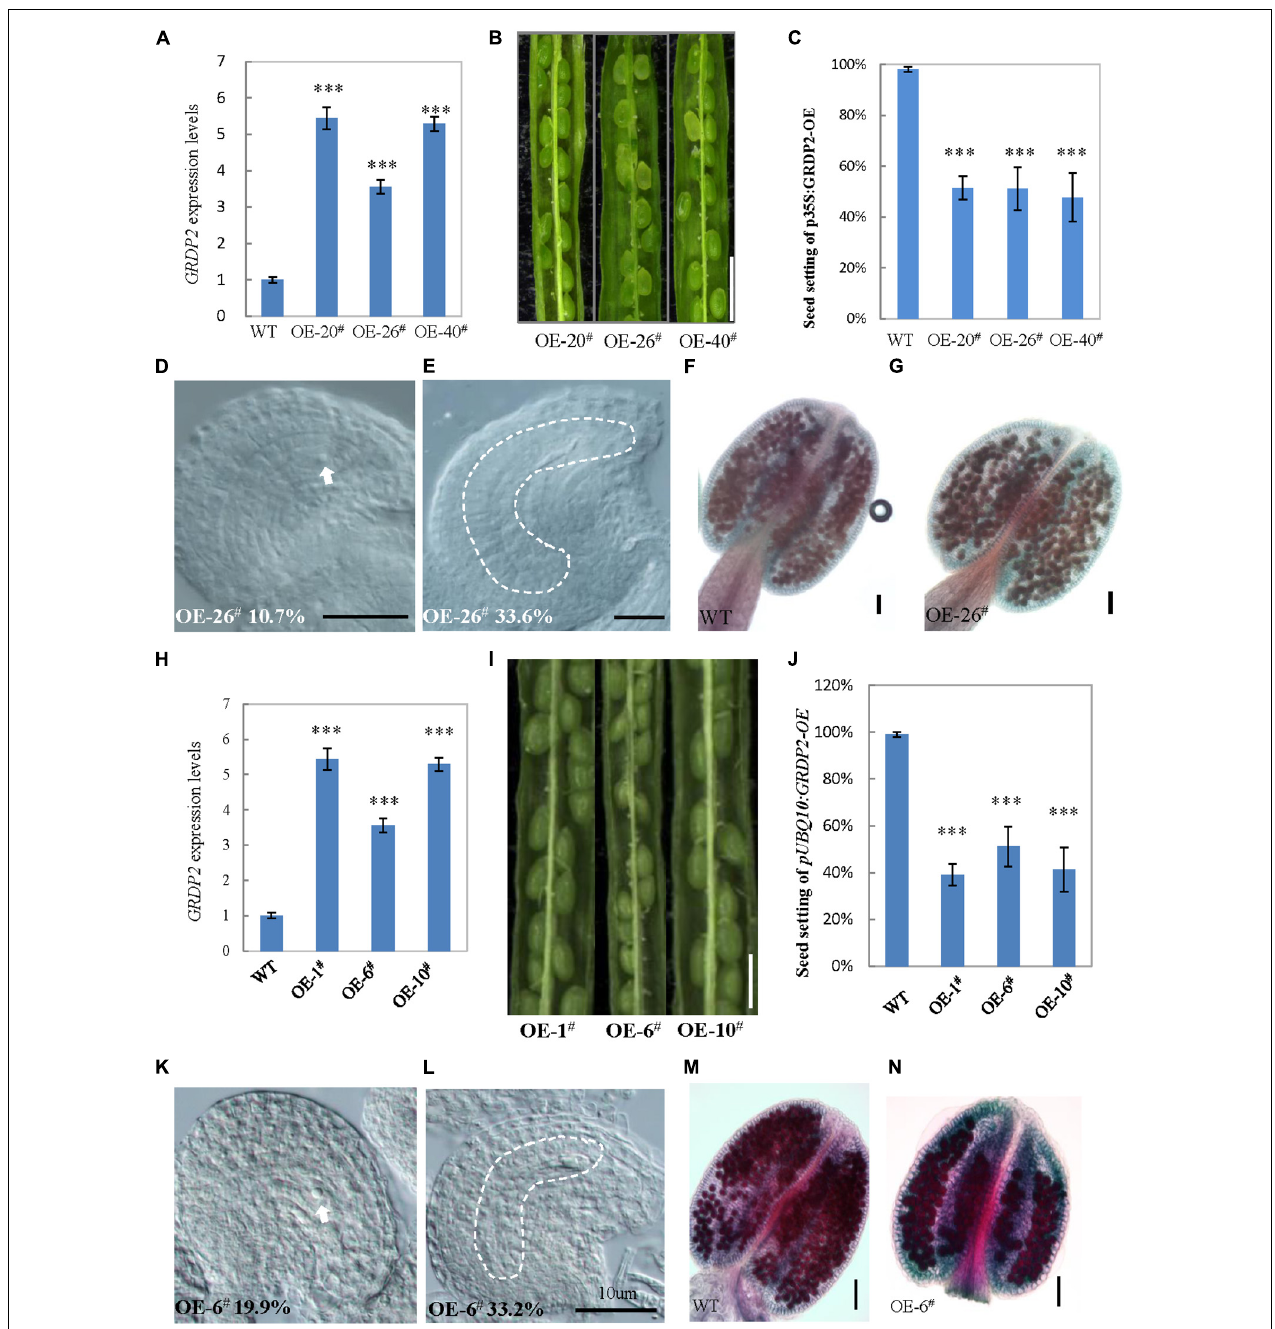
FIGURE 4 | Phenotype analysis of p35S:GRDP2 -OE and pUBQ10:GRDP2 -OE lines. (A) Expression levels of GRDP2 in WT, p35S:GRDP2-OE-20 # , p35S:GRDP2-OE-26 # , and p35S:GRDP2-OE-40 # as determined by real-time RT-PCR. (B) Seed development in three p35S:GRDP2-OE line plants. Bar = 1 cm. (C) Seed setting statistic of the WT, p35S:GRDP2-OE-20 # , p35S:GRDP2-OE-26 # , and p35S:GRDP2-OE-40 # lines. (D,E) 10.7% of 316 examined FG7 stage ovules from p35S:GRDP2-OE-26 # line plants showed single nucleus (D) , 33.6% of 316 examined FG7 stage ovules from p35S:GRDP2-OE-26 # line plants showed no nucleus (E) . (F,G) Alexander’s staining of pollen from WT (F) and p35S:GRDP2-OE-26 # (G) line plants. The red color indicates viable pollen. Bar = 50 µ m. (H) Seed development in wild-type (WT) and three pUBQ10:GRDP2-OE line plants. Bar = 1 cm. (I) Expression levels of GRDP2 in WT, pUBQ10:GRDP2-OE-1 # , pUBQ10:GRDP2-OE-6 # , and pUBQ10:GRDP2-OE-10 # as determined by real-time RT-PCR. (J) Seed setting statistics of the WT, pUBQ10:GRDP2-OE-1 # , pUBQ10:GRDP2-OE-6 # , and pUBQ10:GRDP2-OE-10 # lines. (K,L) The FG7 stage ovules from pUBQ10:GRDP2-OE-26 # line plants. (M,N) Alexander’s staining of pollen from WT (M) and pUBQ10:GRDP2-OE-6 # (N) line plants. The red color indicates viable pollen. Bar = 50 µ m. Vertical bars represent the mean ± SD as determined by two technical replicates of three biological replicates; asterisks show the significance level judged by Student’s t -test ( ∗∗∗ p < 0.01). White dotted lines mean embryo